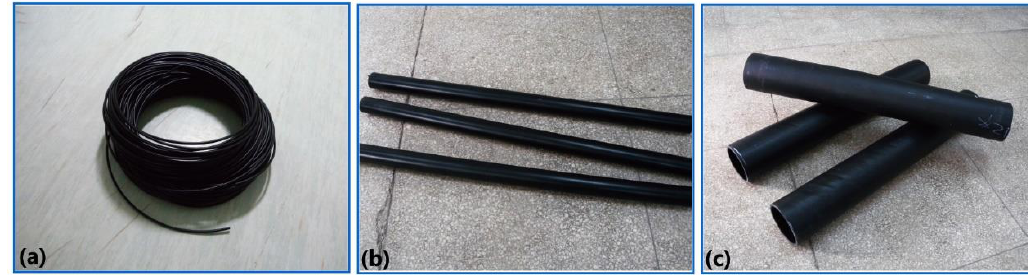
Figure 4. ( a ) Fuel pipes for automobiles, ( b ) fuel pipes for petrol stations and ( c ) fuel pipes used in high pressure applications.